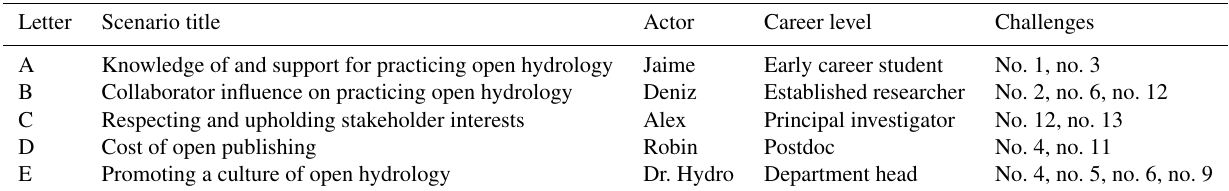
Table A2. Scenario summary